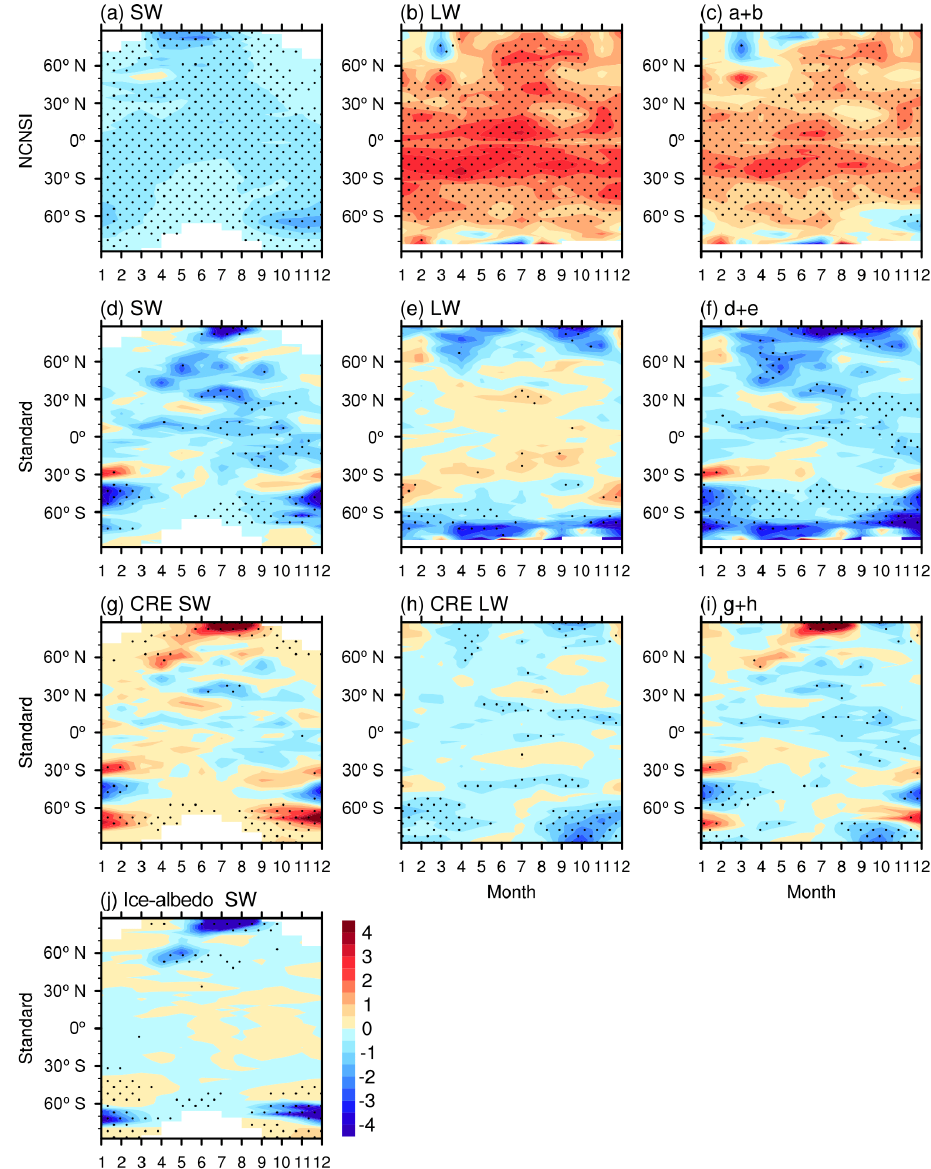
Figure 4. The latitude–month distribution of the responses to SOR of the zonal mean surface radiation budget. (a) Net shortwave, (b) down- ward long wave, and (c) panels (a, b) in the NCNSI experiment. (d) Net shortwave, (e) downward long wave, and (f) panels (d, e) in the Standard experiment. (g) Shortwave CRE, (h) long-wave CRE, and (i) panels (g, h) in the Standard experiment. (j) The albedo-induced surface radiation in the Standard experiment. Color interval is 0.5Wm − 2